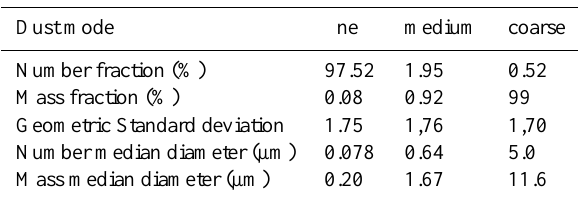
Table 1. Log-normal parameters of the size distribution used in the MesoNH